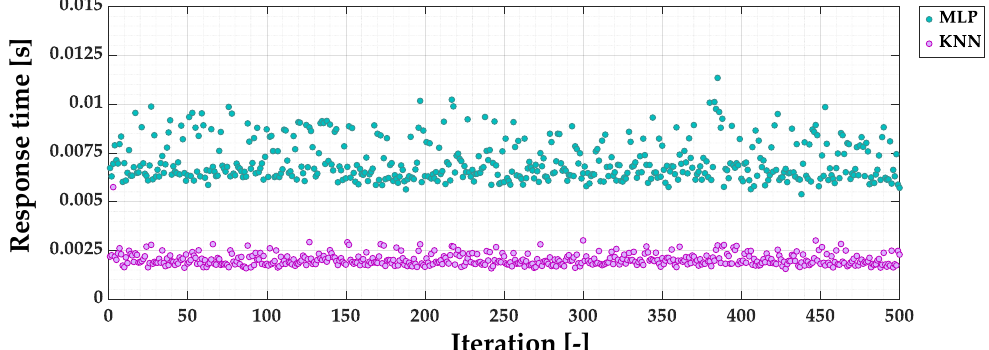
Figure 25. Comparison of the MLP- and KNN-based PM fault detectors response time.